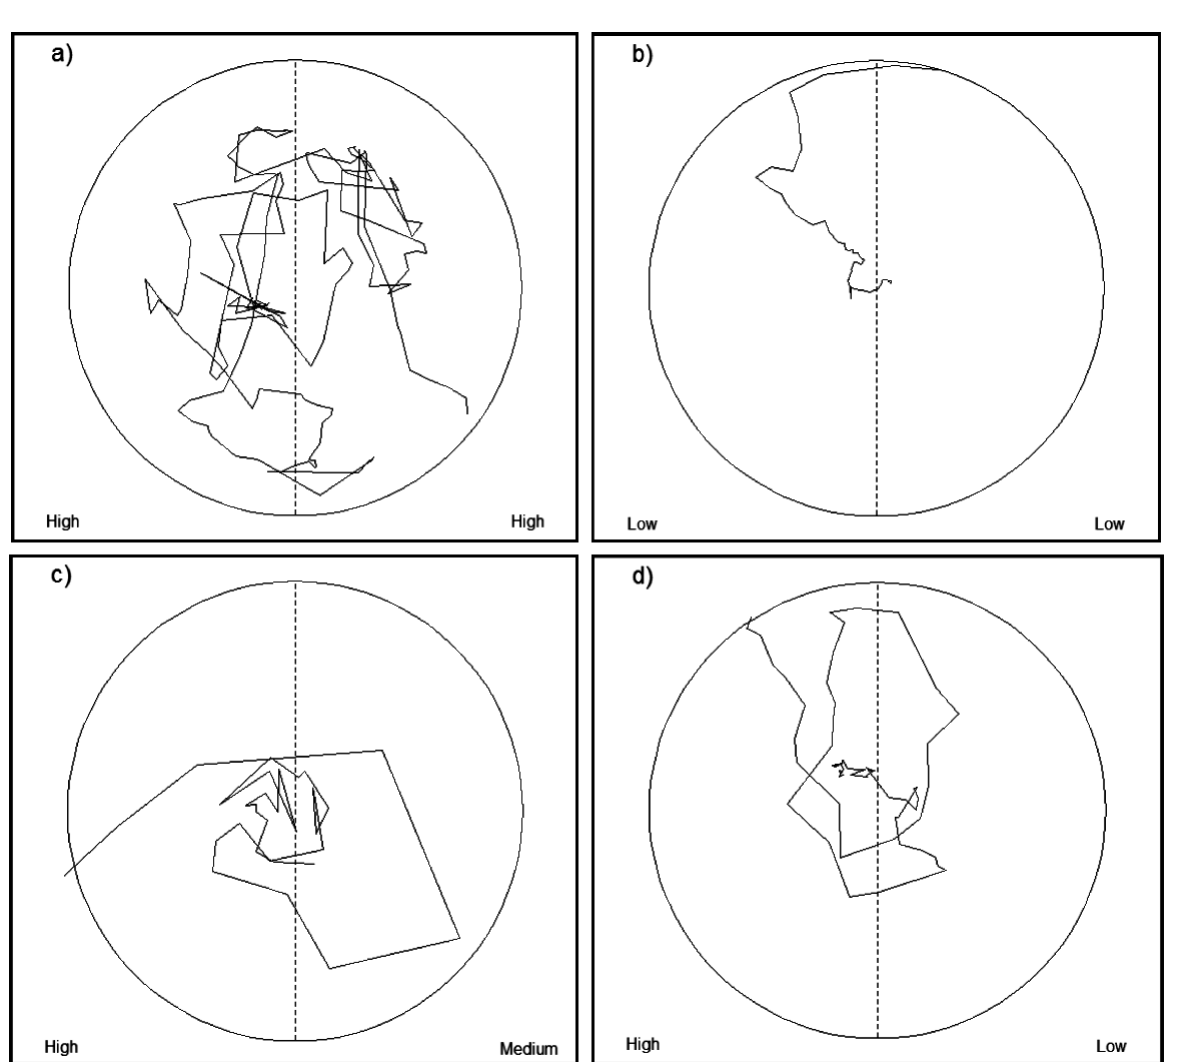
Fig. 2. Types of paths along which California sea cucumbers Parastichopus californicus travelled (all panels with high densities of individuals, i.e. 9 ind. tank −1 ): (a) only high levels (~8%) of total organic matter (TOM), (b) only low levels of TOM (~1.4%), (c) high and medium (~4.4%) levels of TOM and (d) high and low levels of TOM. The dashed vertical line represents the division between TOM treatments. These paths were chosen as they show extremes of any significant differences observed in the